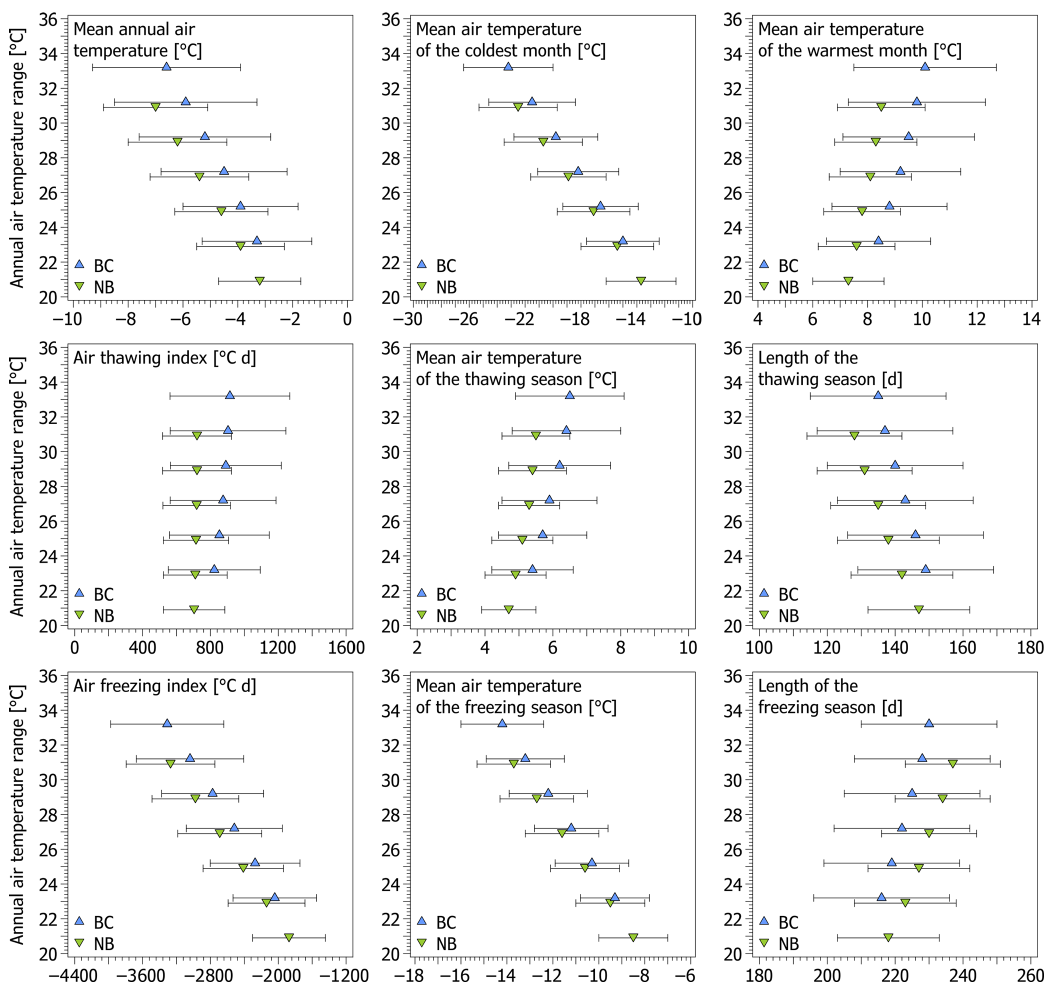
Figure 6. Means and standard deviations of modelled palaeo-air temperature characteristics at the Brno–ˇCernovice (BC) and Nebanice (NB) sites for six scenarios of the annual air temperature